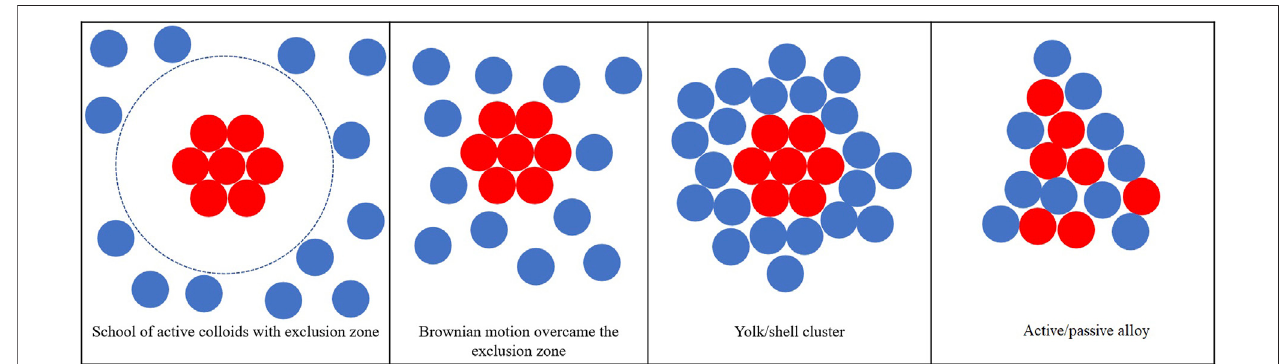
Frontiers in Chemistry |